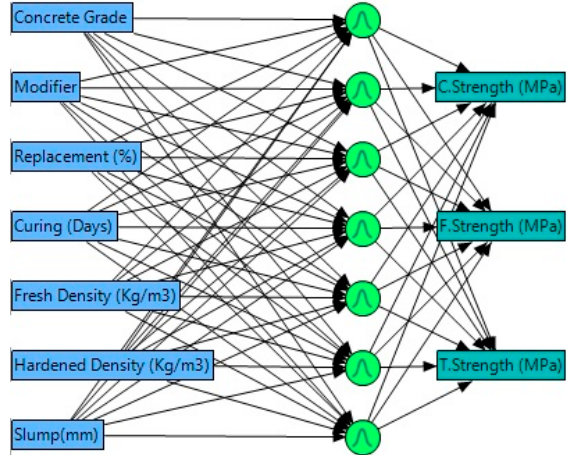
Figure 4. Artificial neural networks structure.